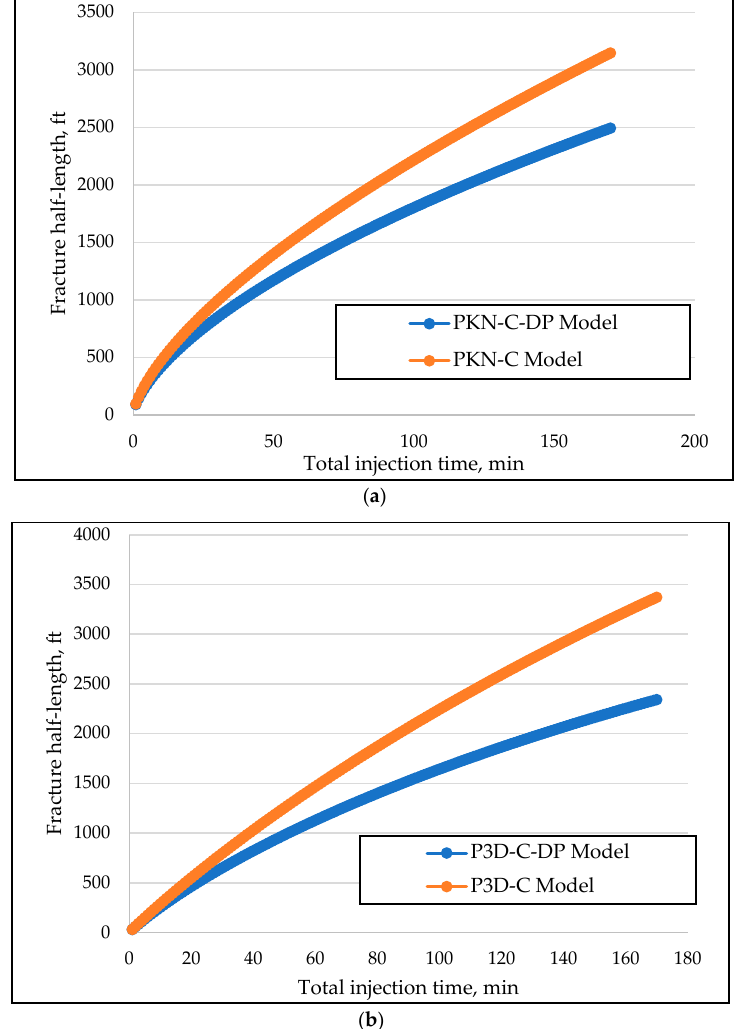
Figure 4. ( a ) Fracture half-length versus total injection time for PKN-C and PKN-C-DP models; ( b ) fracture half-length versus total injection time for P3D-C and P3D-C-DP models. Figure 5a,b indicate that the PKN-C model in the single-porosity system predicts a slightly greater average fracture width and maximum fracture width at the wellbore. In contrast, lower values are obtained from the PKN-C-DP model. This is because a higher leak-off coefficient results in a lower build-up pressure, leading to a narrower fracture width [33]. Similarly, when comparing the single-porosity system to the dual-porosity system, we find that more fluid leak-off occurs in the dual porosity medium resulting in a smaller maximum and average fracture width. Thus, the fracture for the dual-porosity leak-off shrinks and becomes more confined in size compared to the fracture for the sin- gle-porosity leak-off.